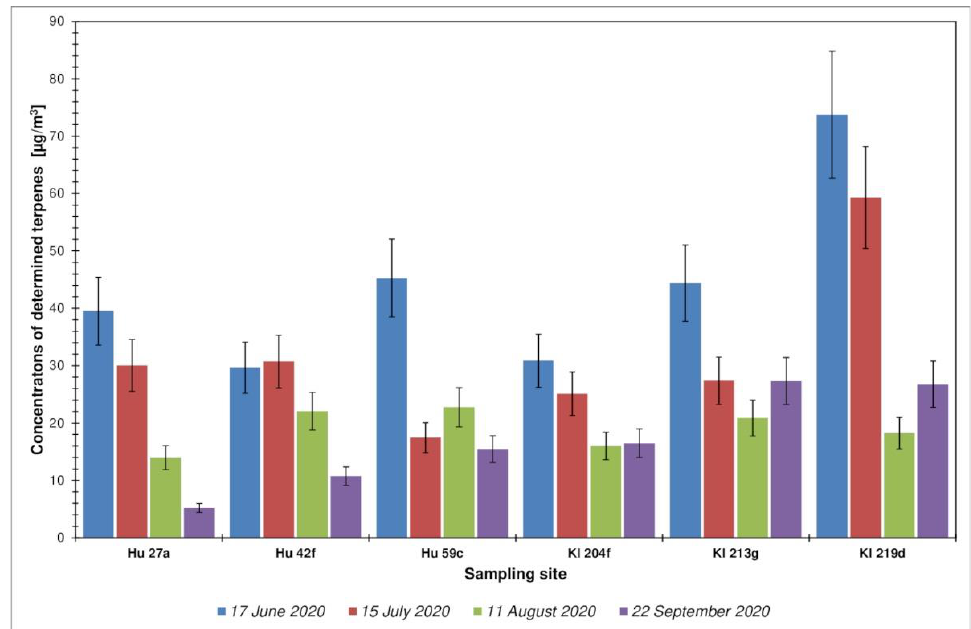
Figure 4. Percentage of terpenes and terpenoids in the total content of volatile organic compounds (TVOC) for each investigated site, in all measurement periods. Error bars express the standard deviation of obtained results.